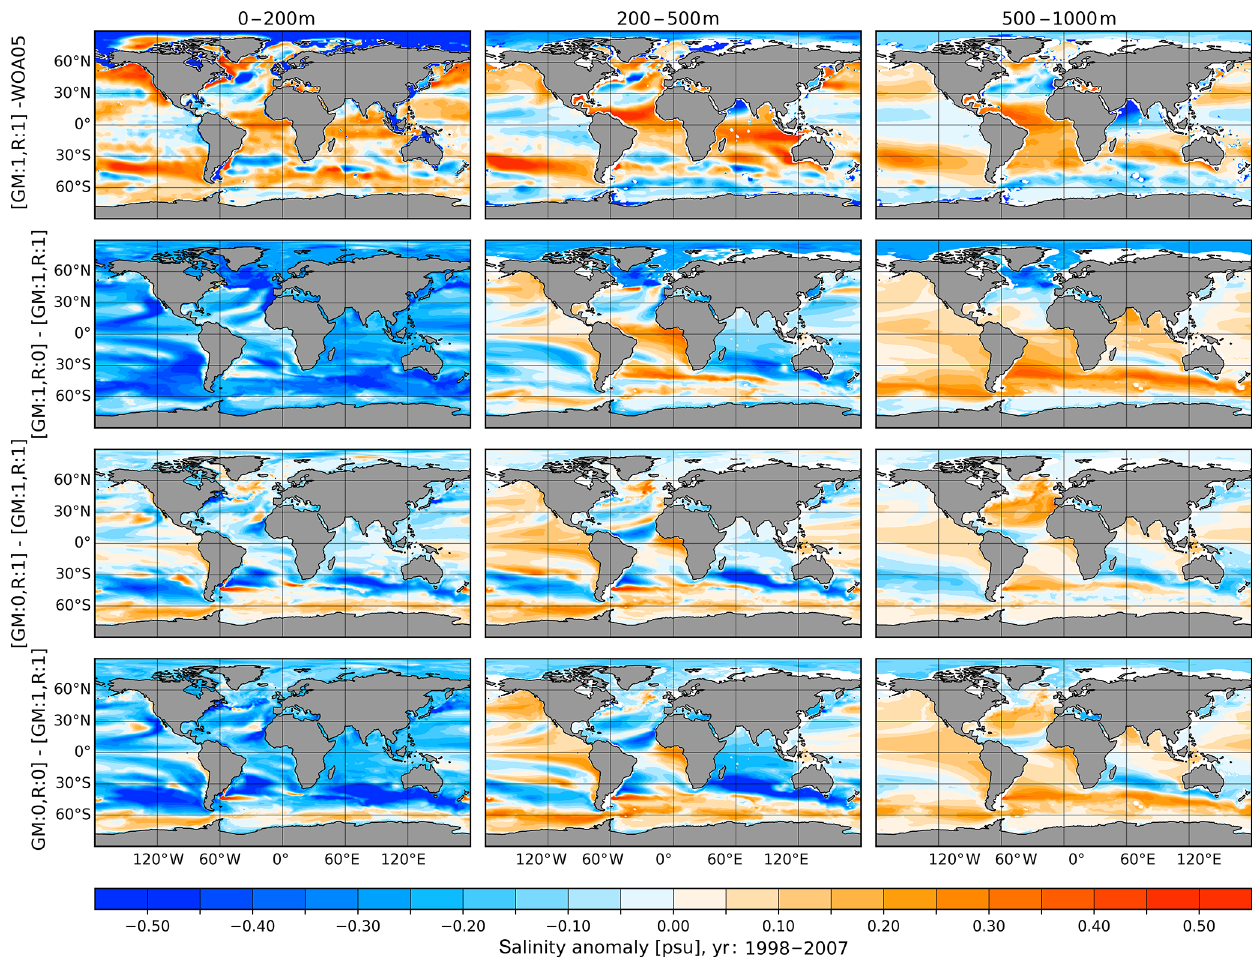
Figure 7. Same as Fig. 6 but for